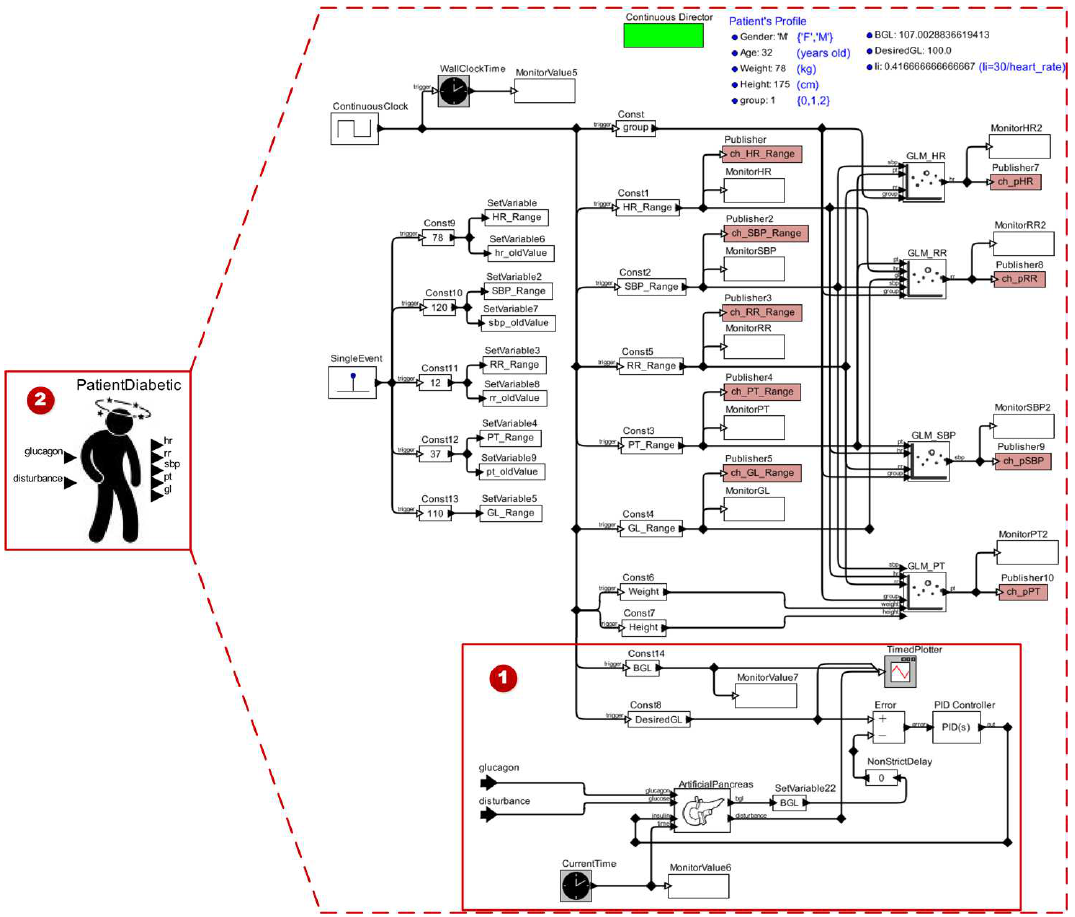
Figure 6. Diabetic Patient